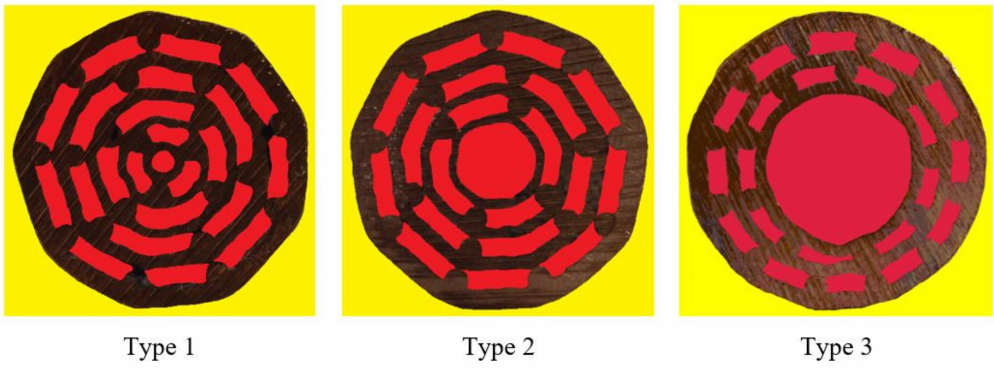
Figure 4. Evaluation of the actual porosity utilizing digital image